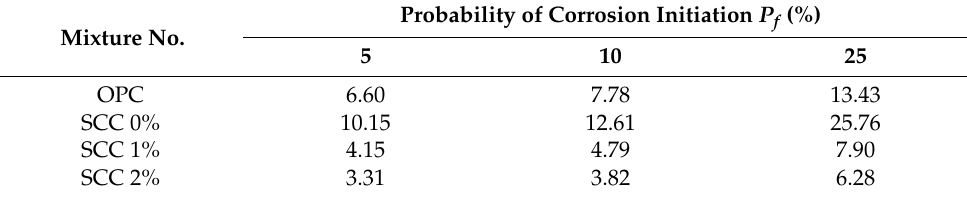
Table 4. Period to the initiation of corrosion, t i (years), for a selected probability of the initiation of corrosion.